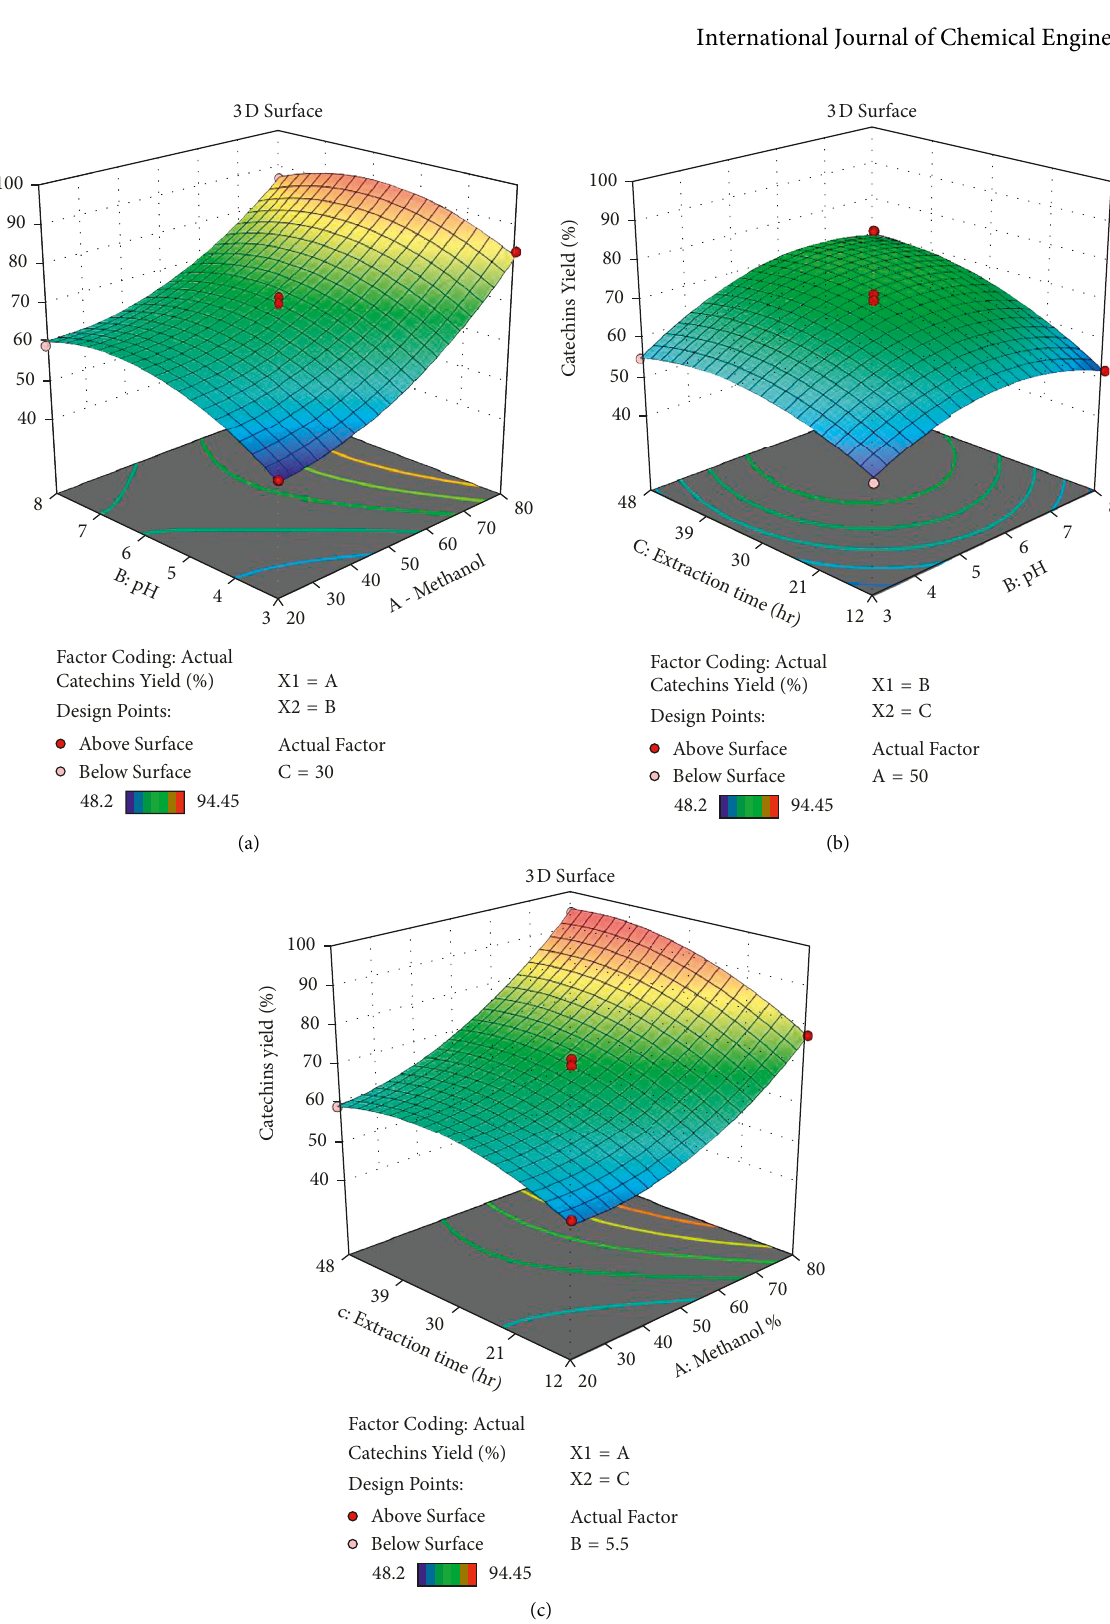
Figure 2: (a) 3D response surface plot of methanol % and pH. (b) 3D response surface plot of extraction time and pH. (c) 3D response surface plot of methanol % and extraction